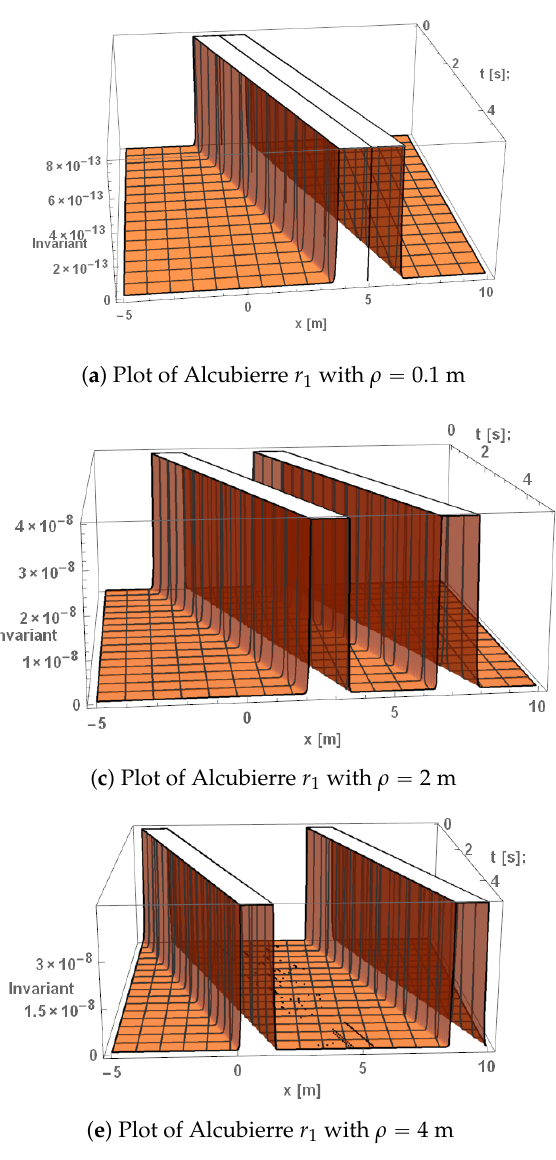
Figure A5. Plots of the r 1 invariants for the Alcubierre warp drive while varying the radius. The other parameters were chosen as σ “ 8 m ´ 1 and v s “ 1 c to match the parameters Alcubierre originally suggested in his paper